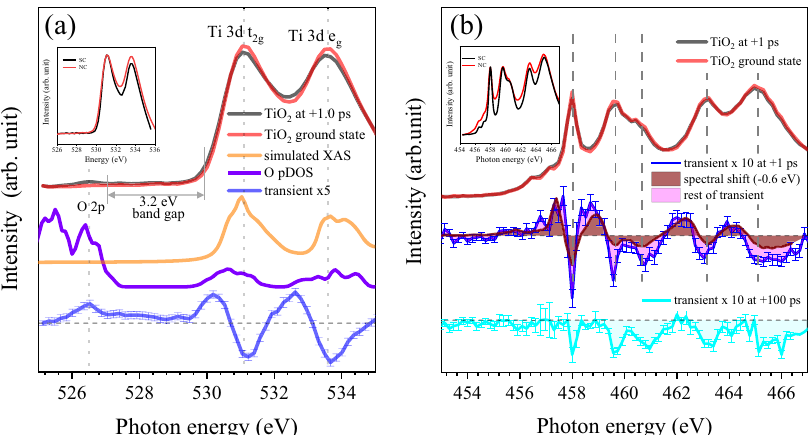
Fig. 2 XAS spectra of 20 nm TiO 2 NC at the oxygen K-edge and the Ti L-edge. a Overview of the oxygen K-edge XAS measured + 1 ps after the pump excitation (black) and the ground states before excitation (red). Simulated XAS (orange) and O pDOS (green) are well matched with measured XAS at the oxygen K-edge. The transient XAS spectrum at + 1 ps is multiplied by 5 times. (blue) (inset) ground state XAS spectra for SC and NC at the oxygen K-edge. b Overview of the Ti L-edge XAS measured + 1 ps after the pump excitation (black) and the ground states before excitation (red) for anatase TiO 2 NC. The transient XAS spectrum at + 1 ps (blue) consists shift-induced component (green) and the other component (pink). The transient XAS spectrum at + 100 ps (cyan) does not show shift induced component. (inset) ground state XAS spectra for SC and NC at the Ti L-edge. Error bars correspond to the standard errors.